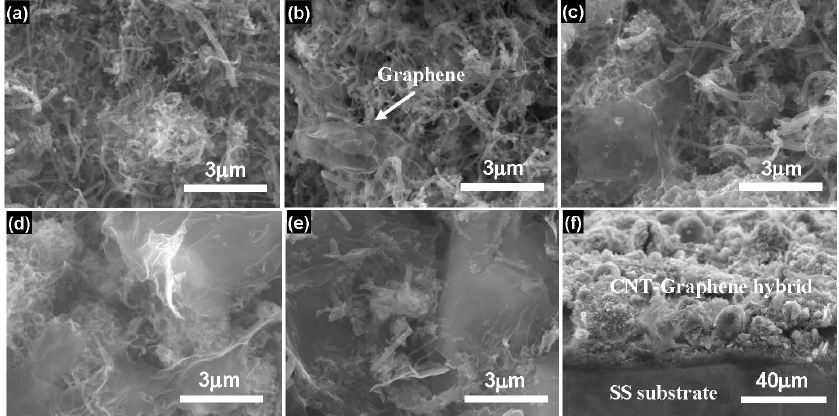
Figure 2. SEM images of the pristine CNTs and CNT-Graphene hybrids. ( a ) the pristine CNTs, ( b – e ) the hybrids obtained by adding 0.04, 0.1, 0.2, and 0.4 g · L − 1 graphenes in the suspension, respectively, ( f ) Cross-section of the CNT-Graphene hybrid. Note: The concentrations of CNTs and Mg 2 + were kept certain values of 0.1 and 0.03 g · L − 1 , respectively [10].